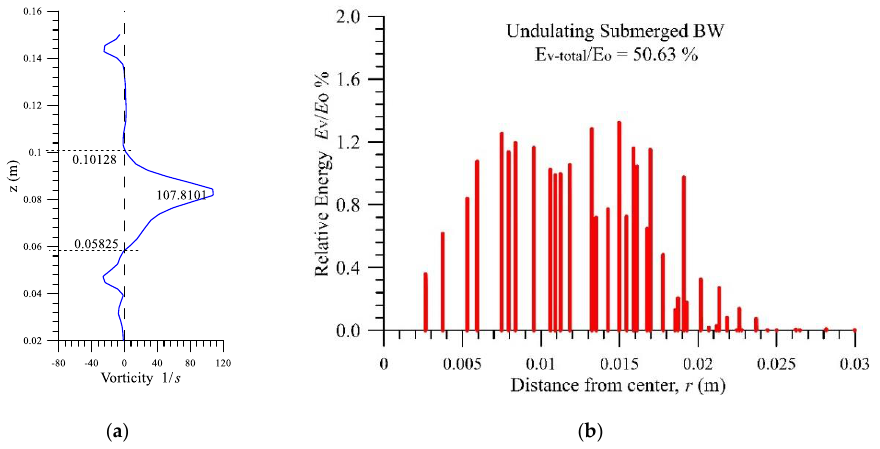
Figure 9. The vorticity and relative energy of the maximum vortex induced by a solitary-like wave propagating over a set of undulating submerged breakwaters: ( a ) the vorticity distribution along the vertical line of the vortex center; ( b ) the relative vortex energy distribution.